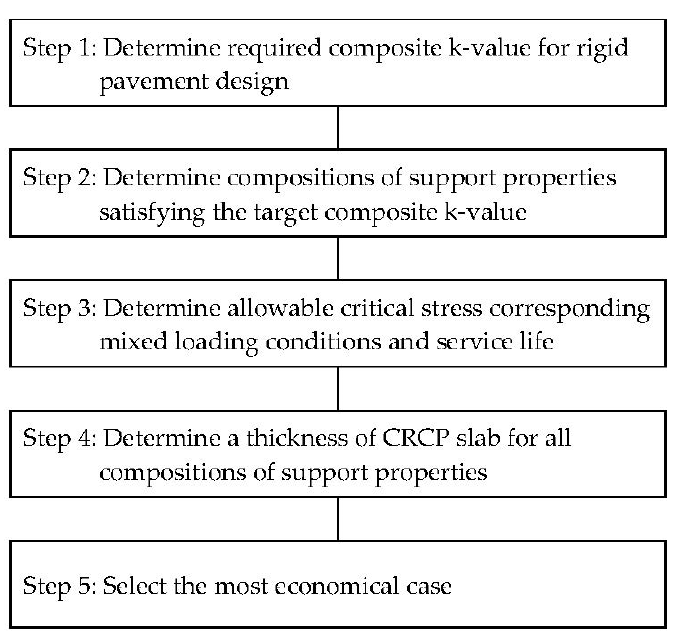
Figure 8. Procedure to determine optimized composition of CRCP